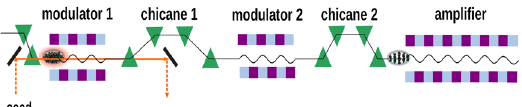
FIG. 2. In an OK-HGHG, we need two pairs of a modulator followed by a chicane. The two modulators are set to the same resonance, chicane 1 is responsible for increasing the bunching at the fundamental wavelength, while chicane 2 is responsible for longitudinal density modulation at a harmonic of the seed laser wavelength. The final FEL amplification of a harmonic of the seed laser wavelength is taking place at the